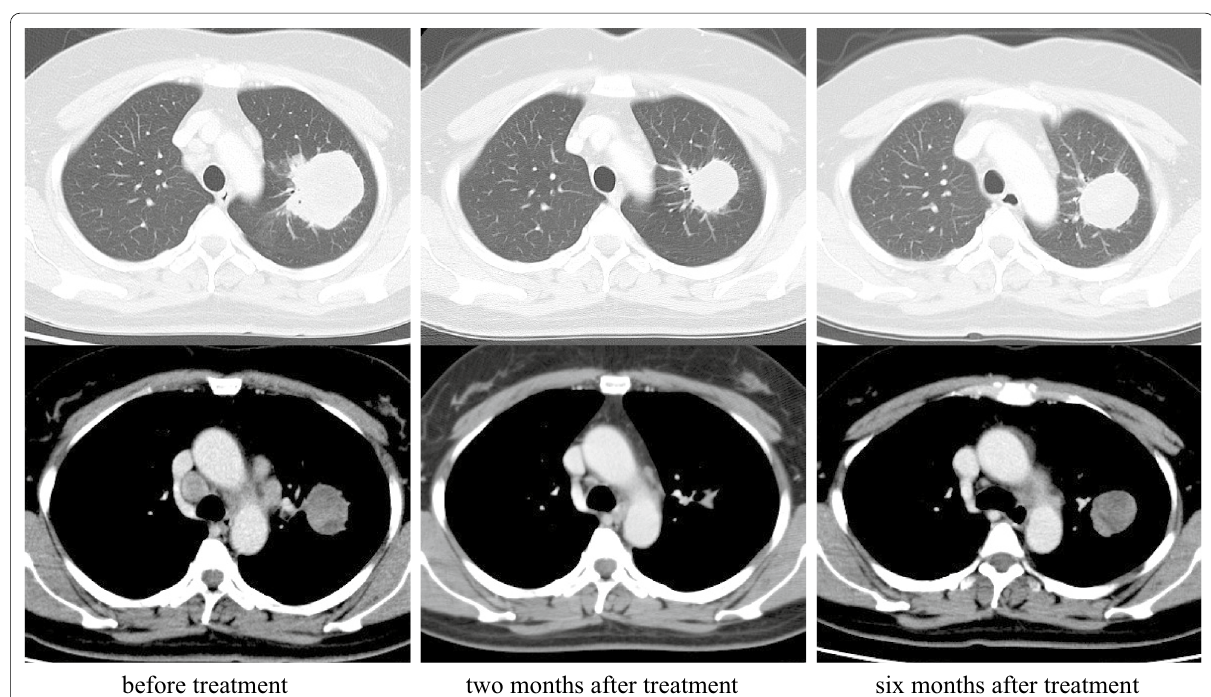
Fig. 2 Computed tomography showed that the lung tumor had regrown, while the lymph nodes had shrunk after 6 months of the alectinib